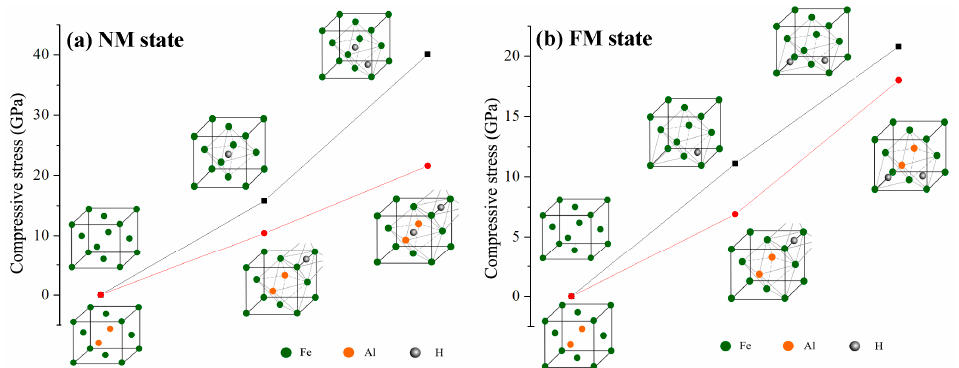
Figure 4. Schematic representation of the change in compressive stress of Al-free and Al-containing austenites in the NM state ( a ) and the FM state ( b ).